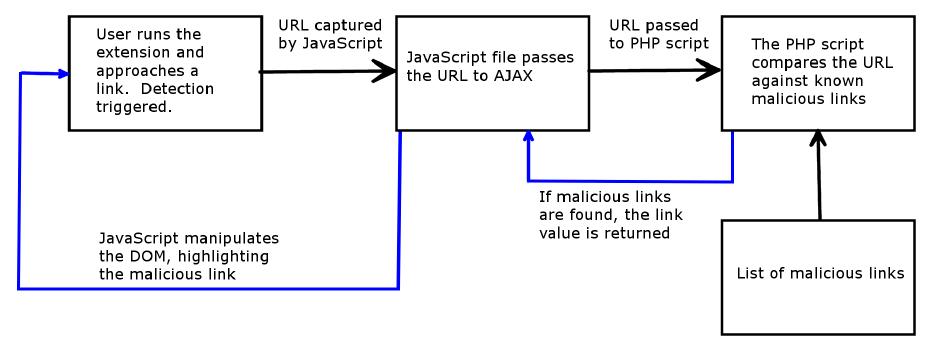
Figure 2. Overview of the Link Detector